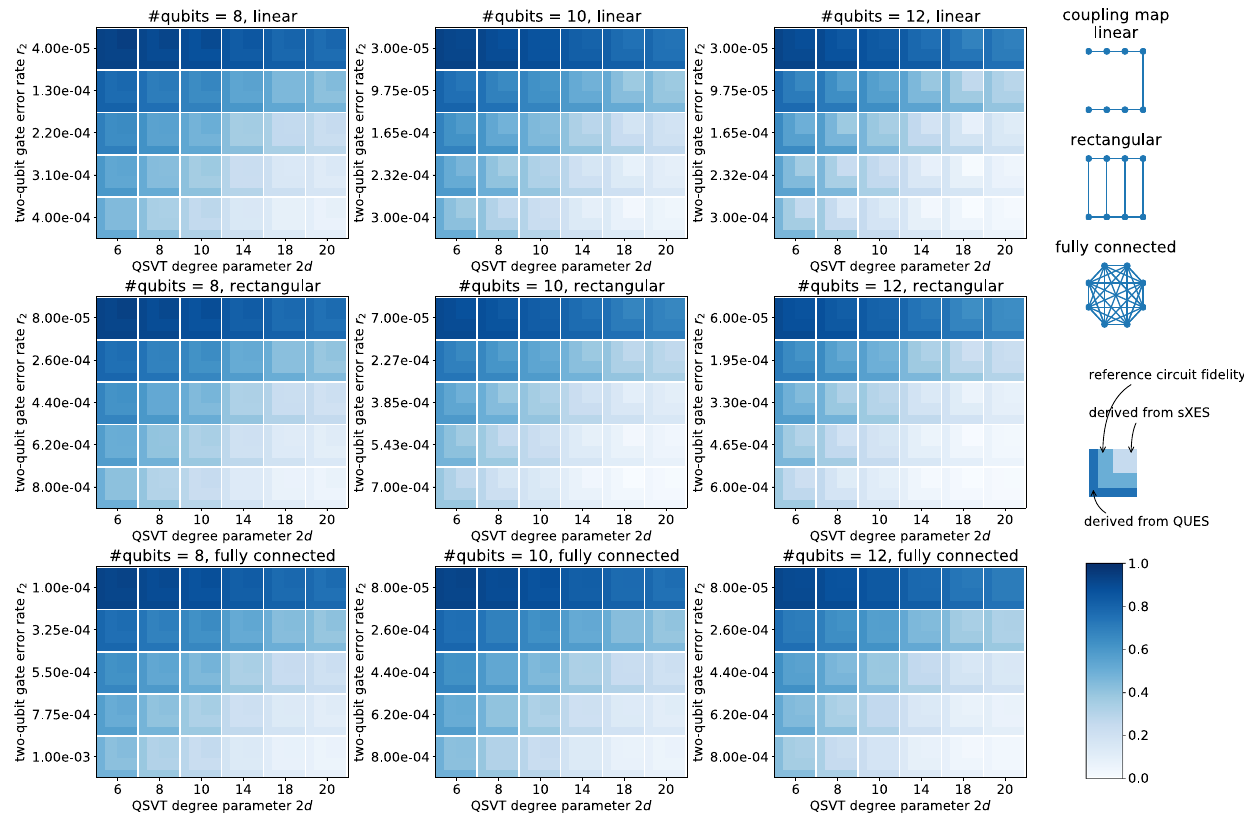
Fig. 3 Circuit fi delity estimated from the quantum Hamiltonian simulation benchmark. Colored grids represent the circuit fi delity estimated from ~100 circuit repetitions. The benchmarking is performed for circuits with a range of number of system qubits, having also variable types of couplings and a range of error parameters. The depth of the random circuit instances is set to the convergent depth deduced from the convergence to Haar measure (see Supplementary Note 7). The right column contains graphical depictions of the coupling maps, the layout of each grid, and the color